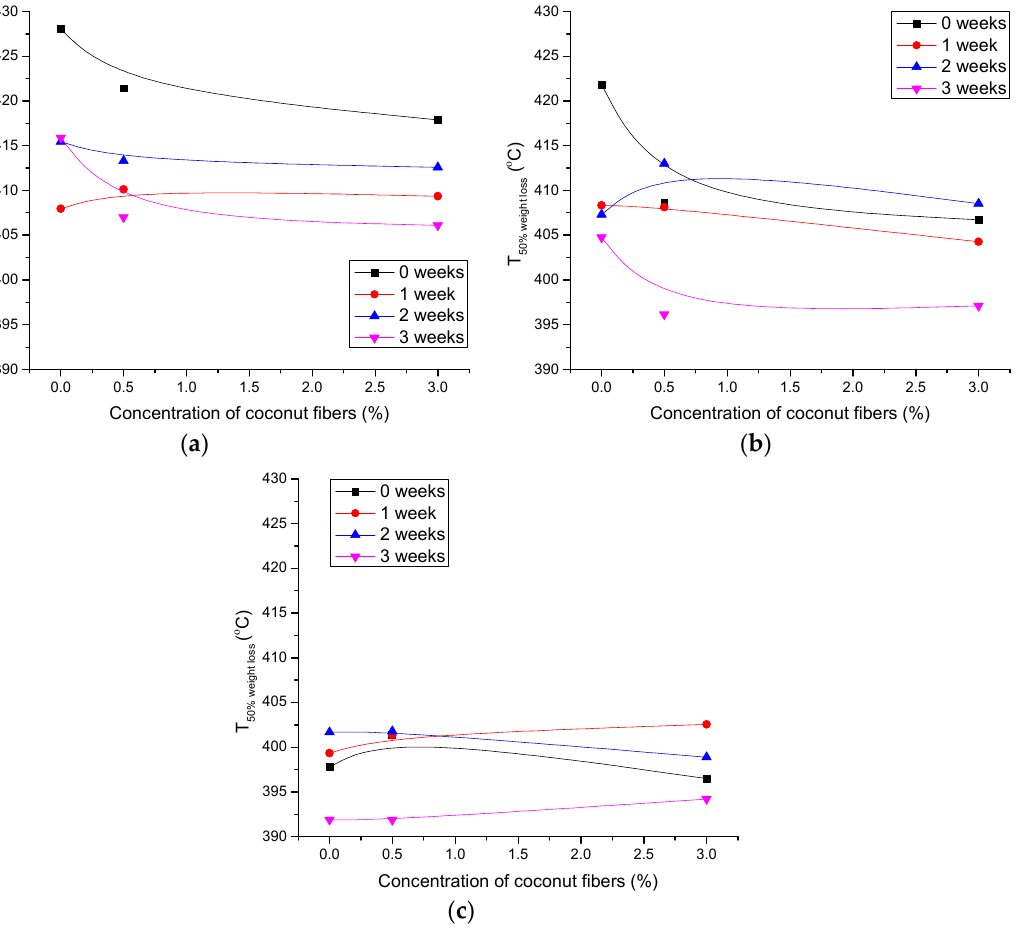
Figure 6. 50% weight loss temperature for polymer blends as a function of coconut fiber concentration: ( a ) PCL-0, ( b ) PCL/PLA 80/20 and ( c ) PCL/PLA 70/30.